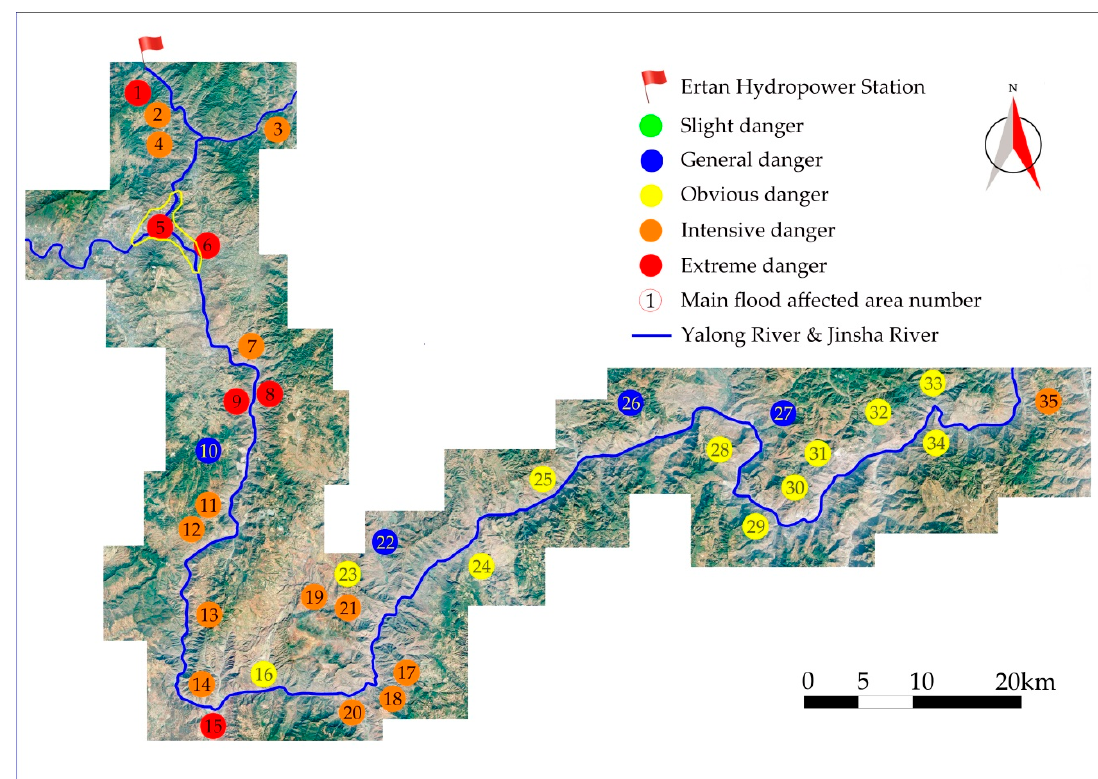
Figure 4. Flood risk map.